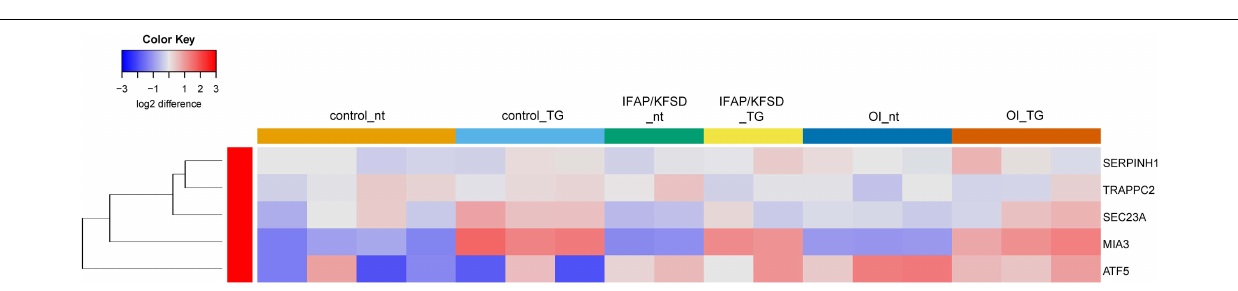
FIGURE 6 | Heatmap depicting expression levels of genes that are transcriptionally regulated by BBF2H7 at basal conditions (nt: no treatment) and in the presence of thapsigargin (TG). The dendrogram on the left y-axis shows clustering of the